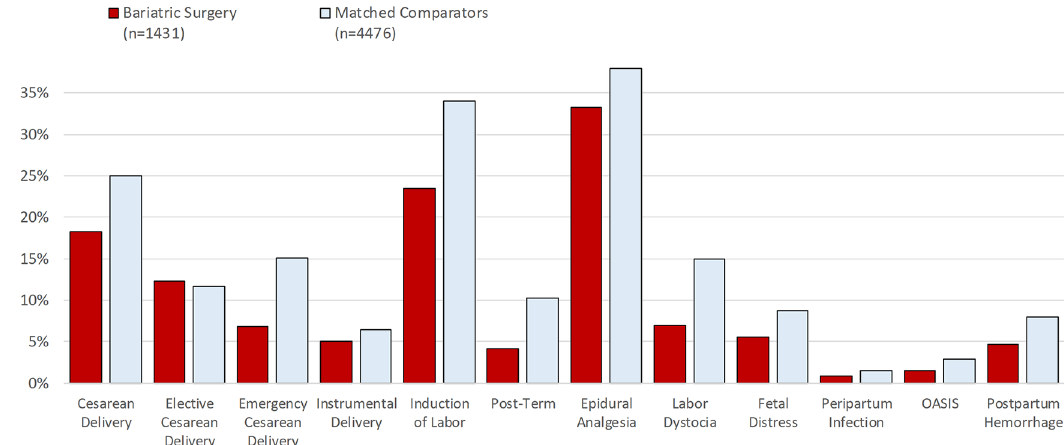
Fig 2. Delivery outcomes after bariatric surgery and in matched general population controls (cid:3) . Elective cesarean deliveries were excluded in the analysis of emergency cesarean delivery, instrumental delivery, induction of labor, epidural analgesia, labor dystocia, and fetal distress (bariatric surgery: N = 1,255; matched comparators: N = 3,952). Cesarean deliveries were excluded in the analysis of OASIS (bariatric surgery: N = 1,170; matched comparators: N = 3,355). OASIS = obstetric anal sphincter injury (perineal tear grade III–IV). Emergency cesarean delivery = all unplanned cesarean sections. (cid:3) Matching factors: maternal age, parity, pre-surgery BMI category (using early-pregnancy BMI in controls), early-pregnancy smoking status, educational level, height, country of birth, and delivery year.